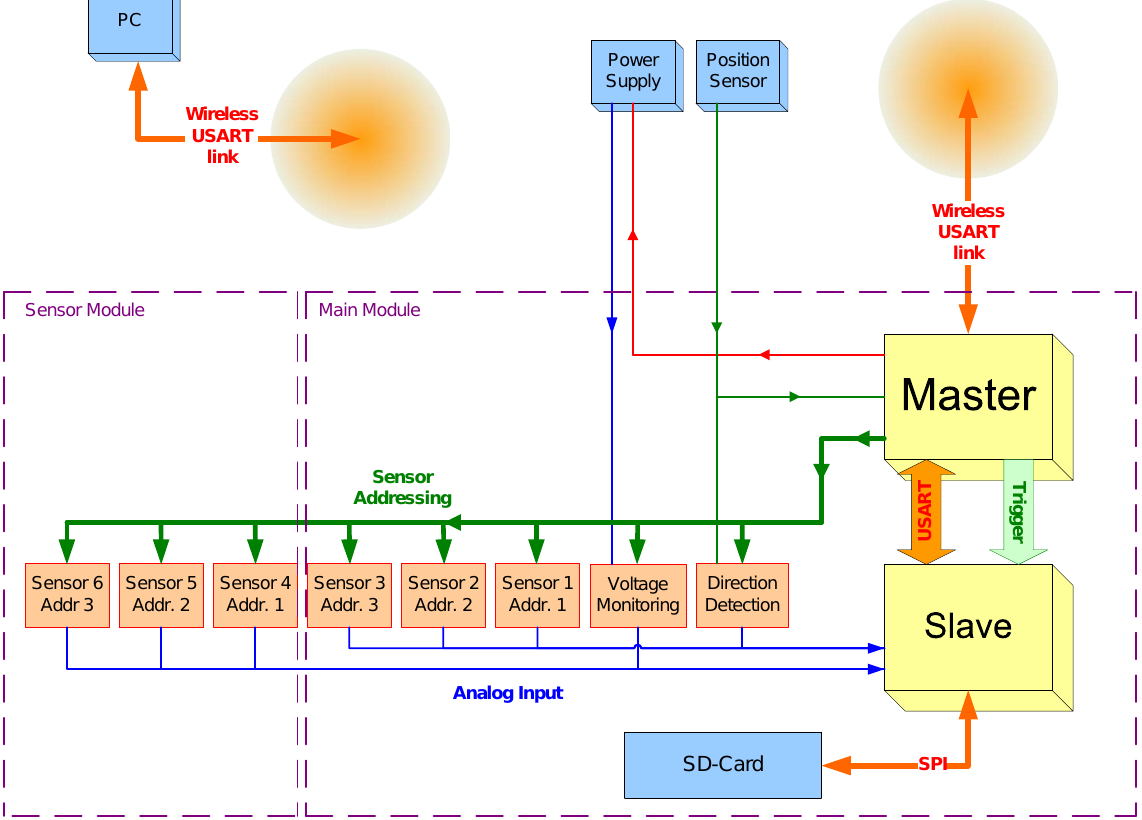
Figure 2. Sensing and data acquisition system in the inspection